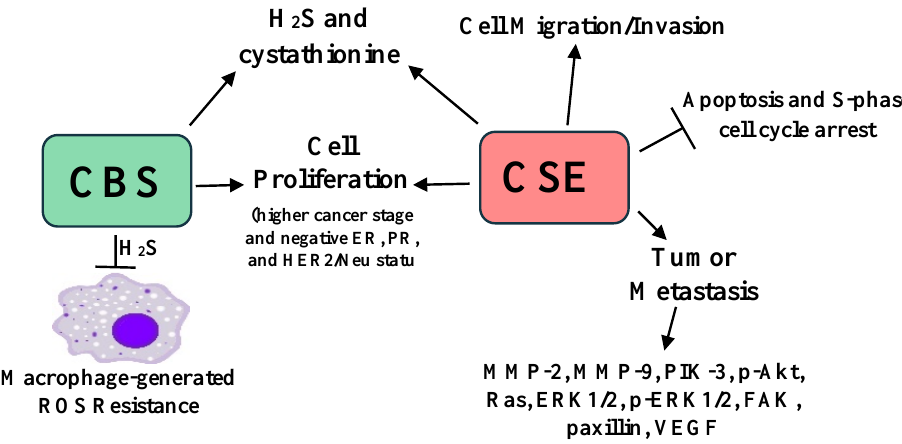
Figure 3. A summary of the roles of CBS, CSE, and H2S in breast cancer growth, progression, metastasis, chemotherapy resistance, and resistance to macrophage-generated ROS [54 – 59].